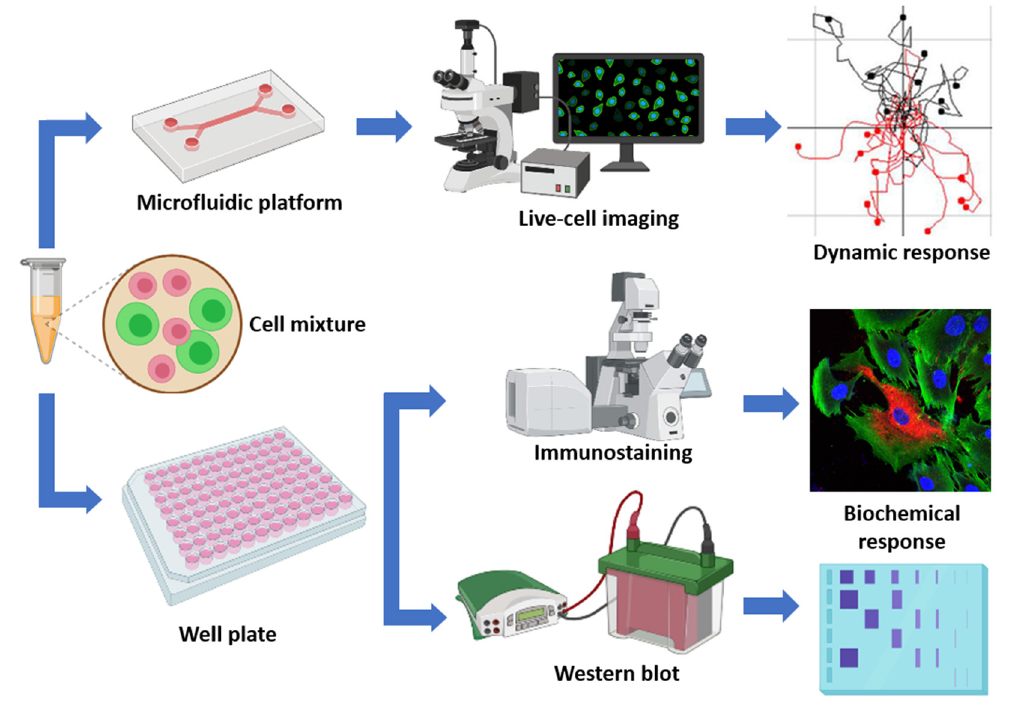
Figure 5. In vitro tumor microenvironment workflow allowing analysis of tumor cell growth and migration, immunohistochemical staining, and immunoblotting under varying degrees of co-culture conditions (Schematic created with